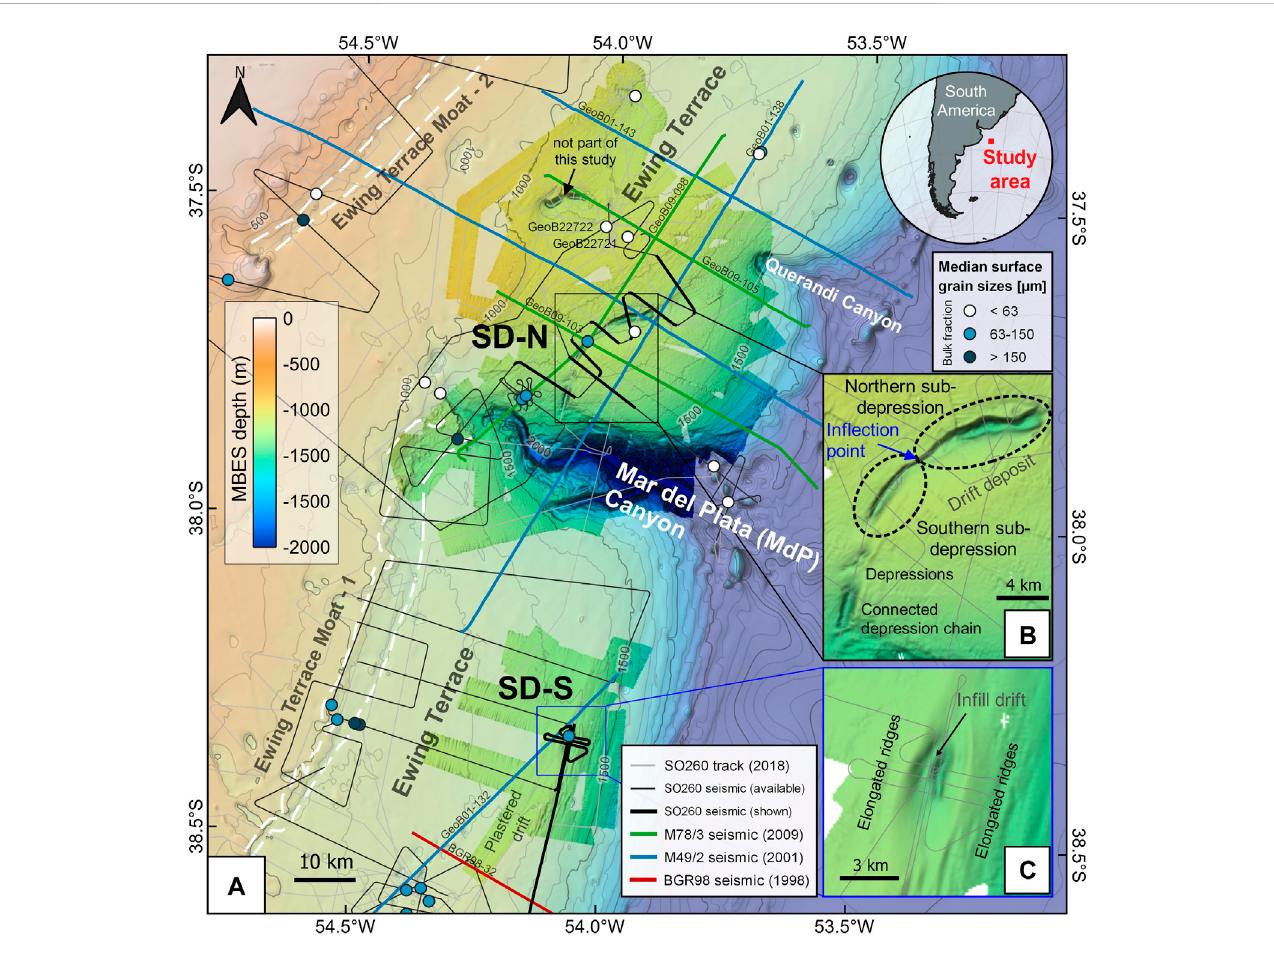
FIGURE 1 StudyarealocatedatthenorthernArgentinecontinentalmargin. (A) Overviewmap. (B) SD-Nand (C) SD-Sindicatetheanalyzedsea fl oordepressionson thenorthernandsouthernEwingTerrace,respectively.OutlineofEwingTerraceMoatsadaptedfromSteinmannetal.(2020)andWilckensetal.(2021a).Grain sizes of surface sediment samples from Wilckens et al. (2021b), available at DOI:10.1594/PANGAEA.931224. Relevant seismic pro fi les with color-coding representing different cruises (cf. Section 3.1). Processed multibeam bathymetry acquired during cruise SO260 overlays regional bathymetry from the GEBCO 2021 Grid (GEBCO Compilation Group,